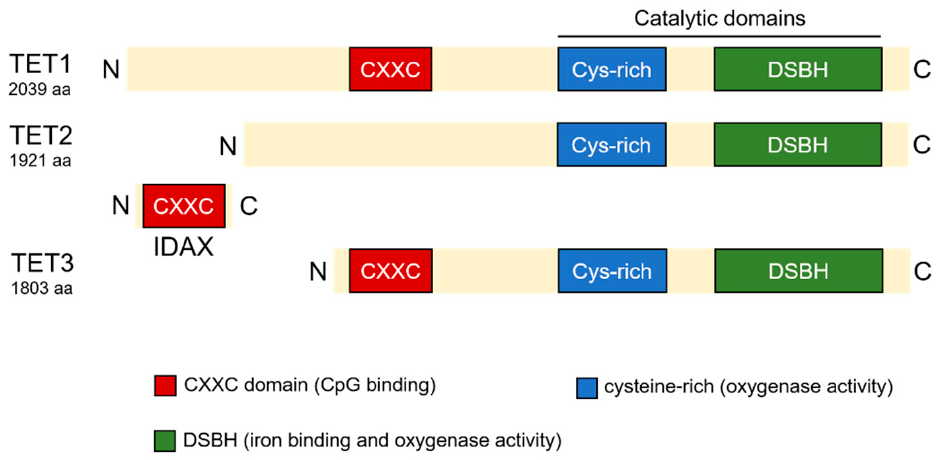
Figure 1. The structure of TET proteins.